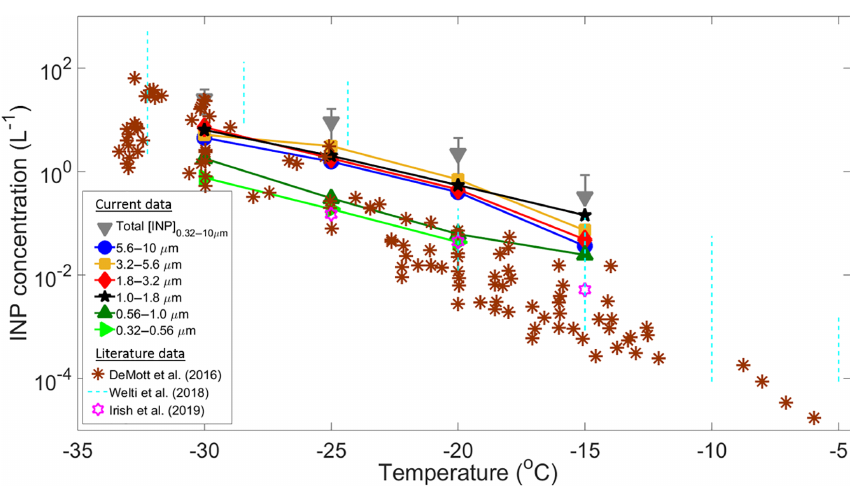
Figure 4. Summary of average INP concentrations as a function of temperature and particle size (solid symbols). Total [INP] are represented by the grey triangles, whereas the brown asterisks, light blue dotted lines, and purple stars are data from DeMott et al. (2016), Welti et al. (2018), and Irish et al. (2019), respectively. The upper and lower detection limits of the MOUDI-DFT are 30 and 0.01L − 1 .